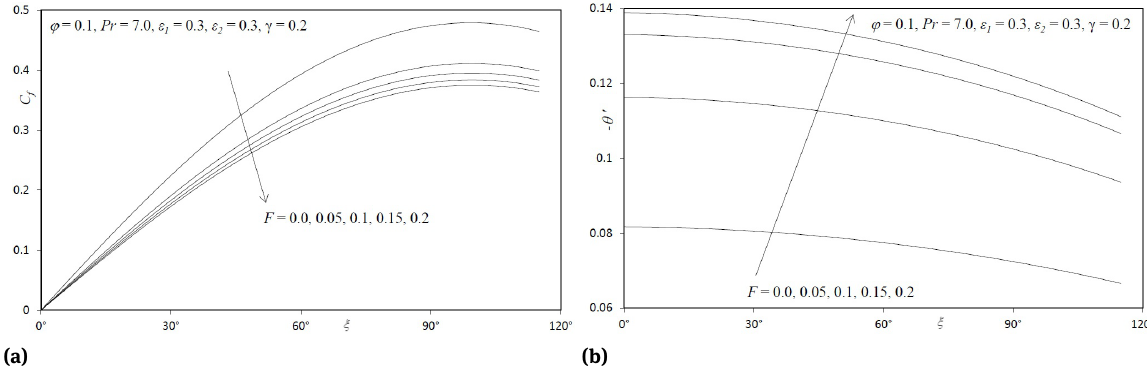
Fig. 13: (a) Effect of F on Skin Friction; (b) Effect of F on Nusselt number